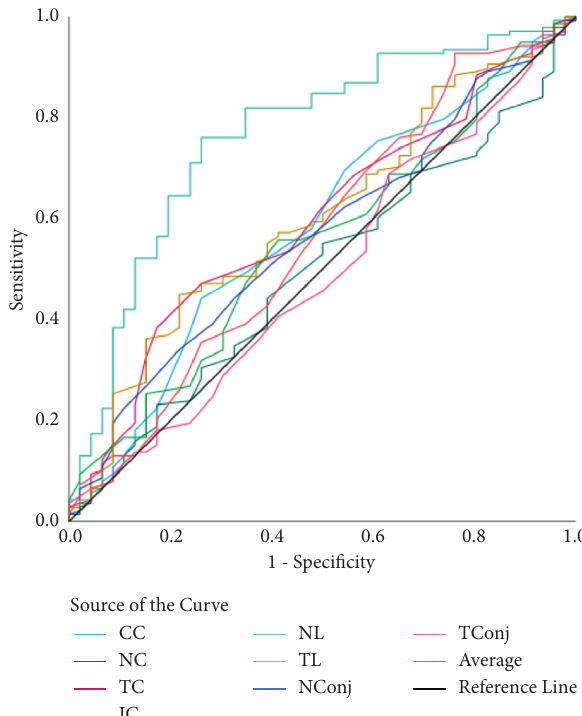
Figure 3: ROC curves of ocular surface temperature for mild dry eye disease. ROC curves represent the mild dry eye disease group vs. nondry eye, moderate dry eye, and severe dry eye groups.